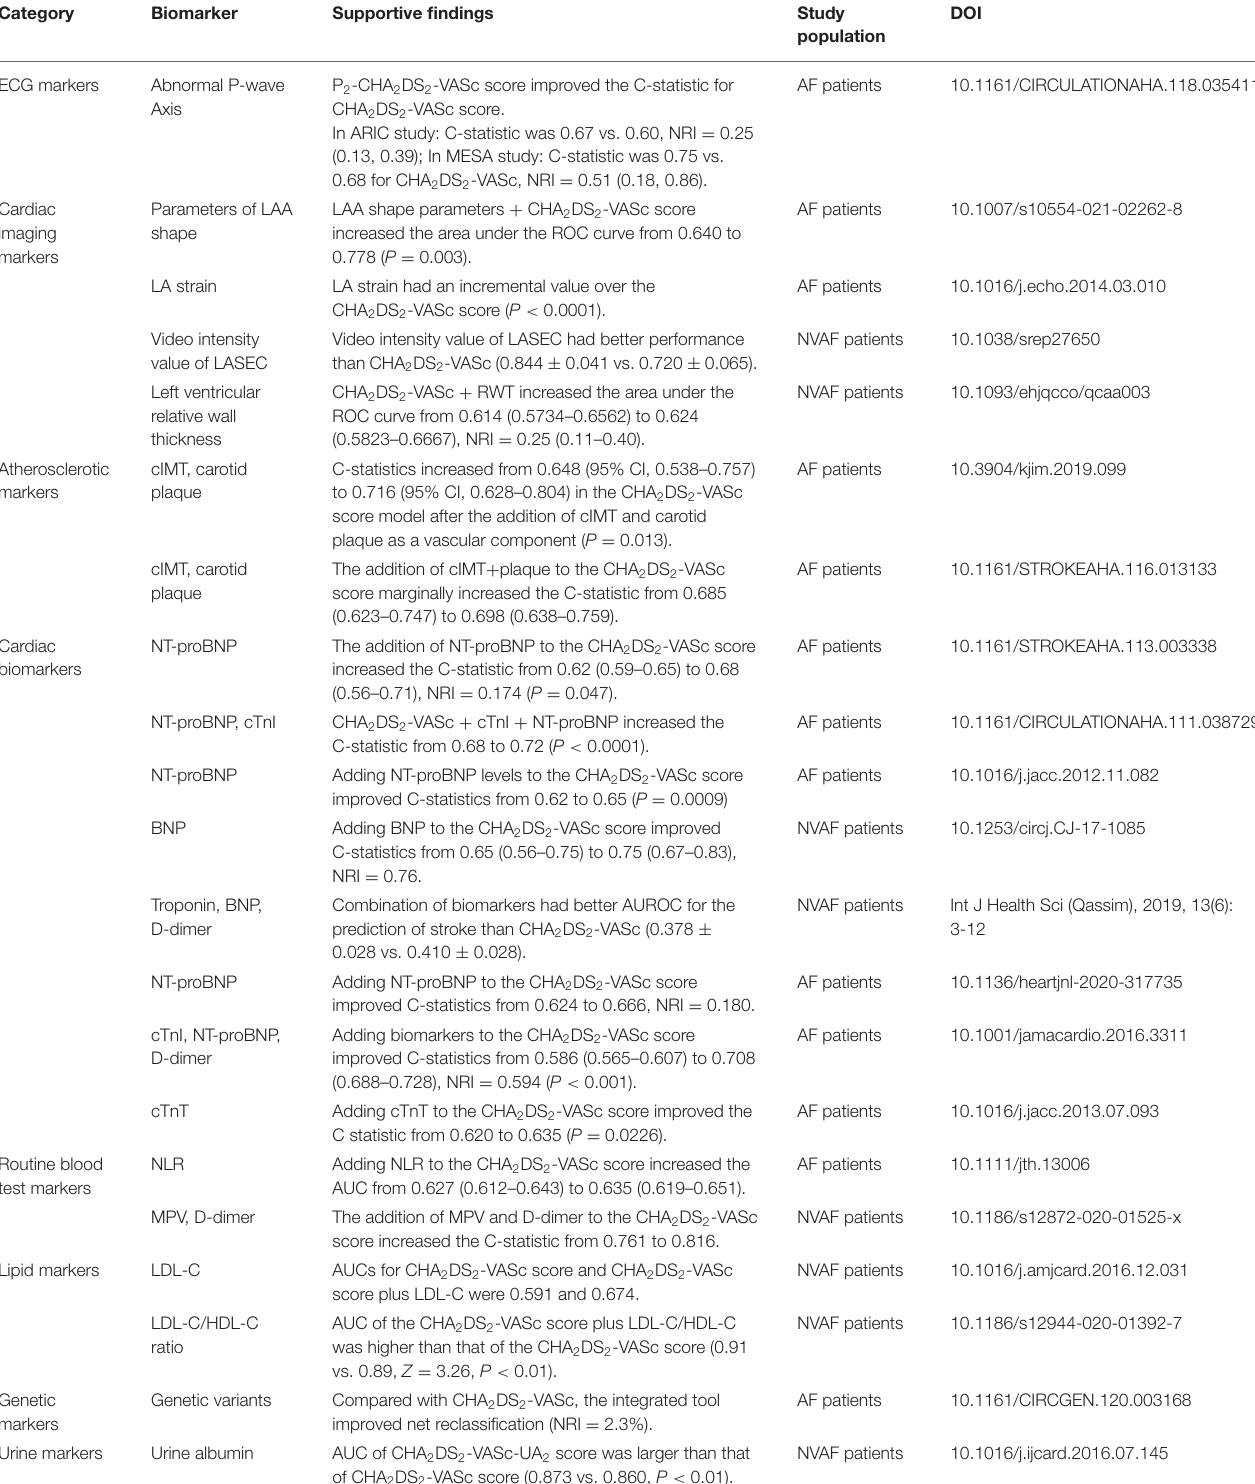
TABLE 2 | Major verified biomarkers adding in stroke/TE risk stratification beyond CHA 2 DS 2 -VASc score in AF patients.